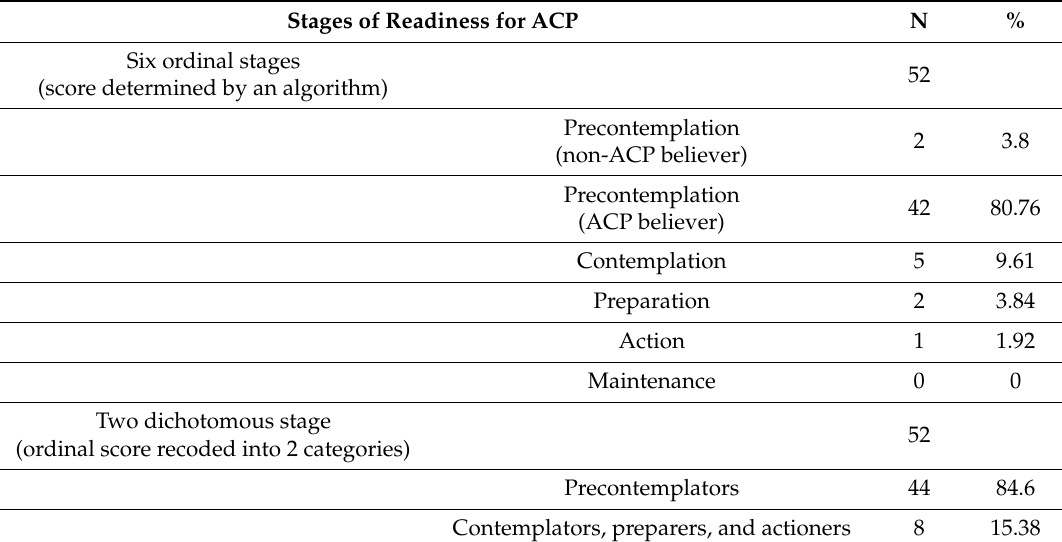
Table 3. Descriptives of the ordinal and dichotomous stages of readiness for advance care planning